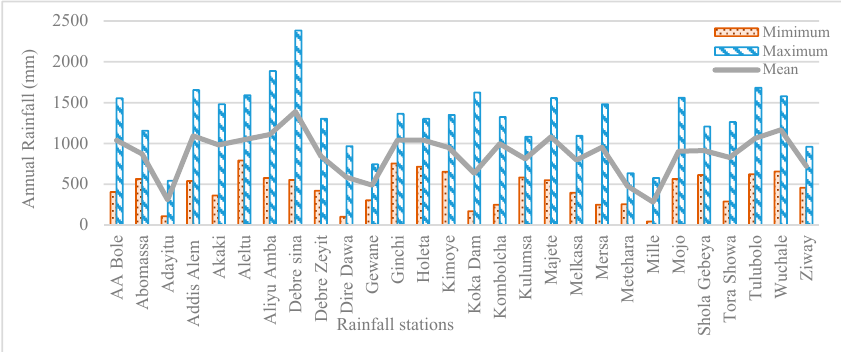
Figure 3. The annual rainfall (mm) in ABR for the 28 rainfall stations .